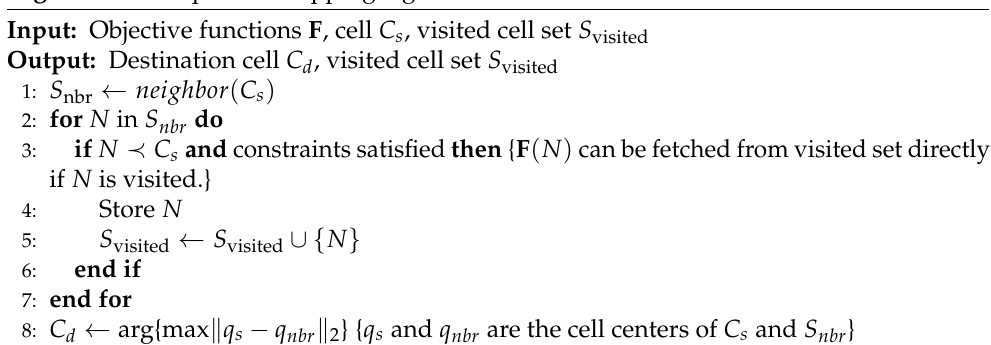
Algorithm 3 Simple cell mapping